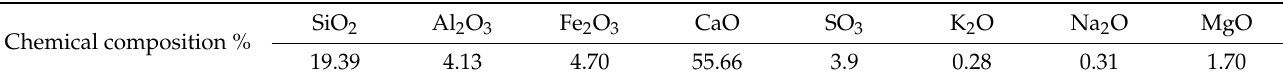
Table 2. Chemical compositions of the used cement.